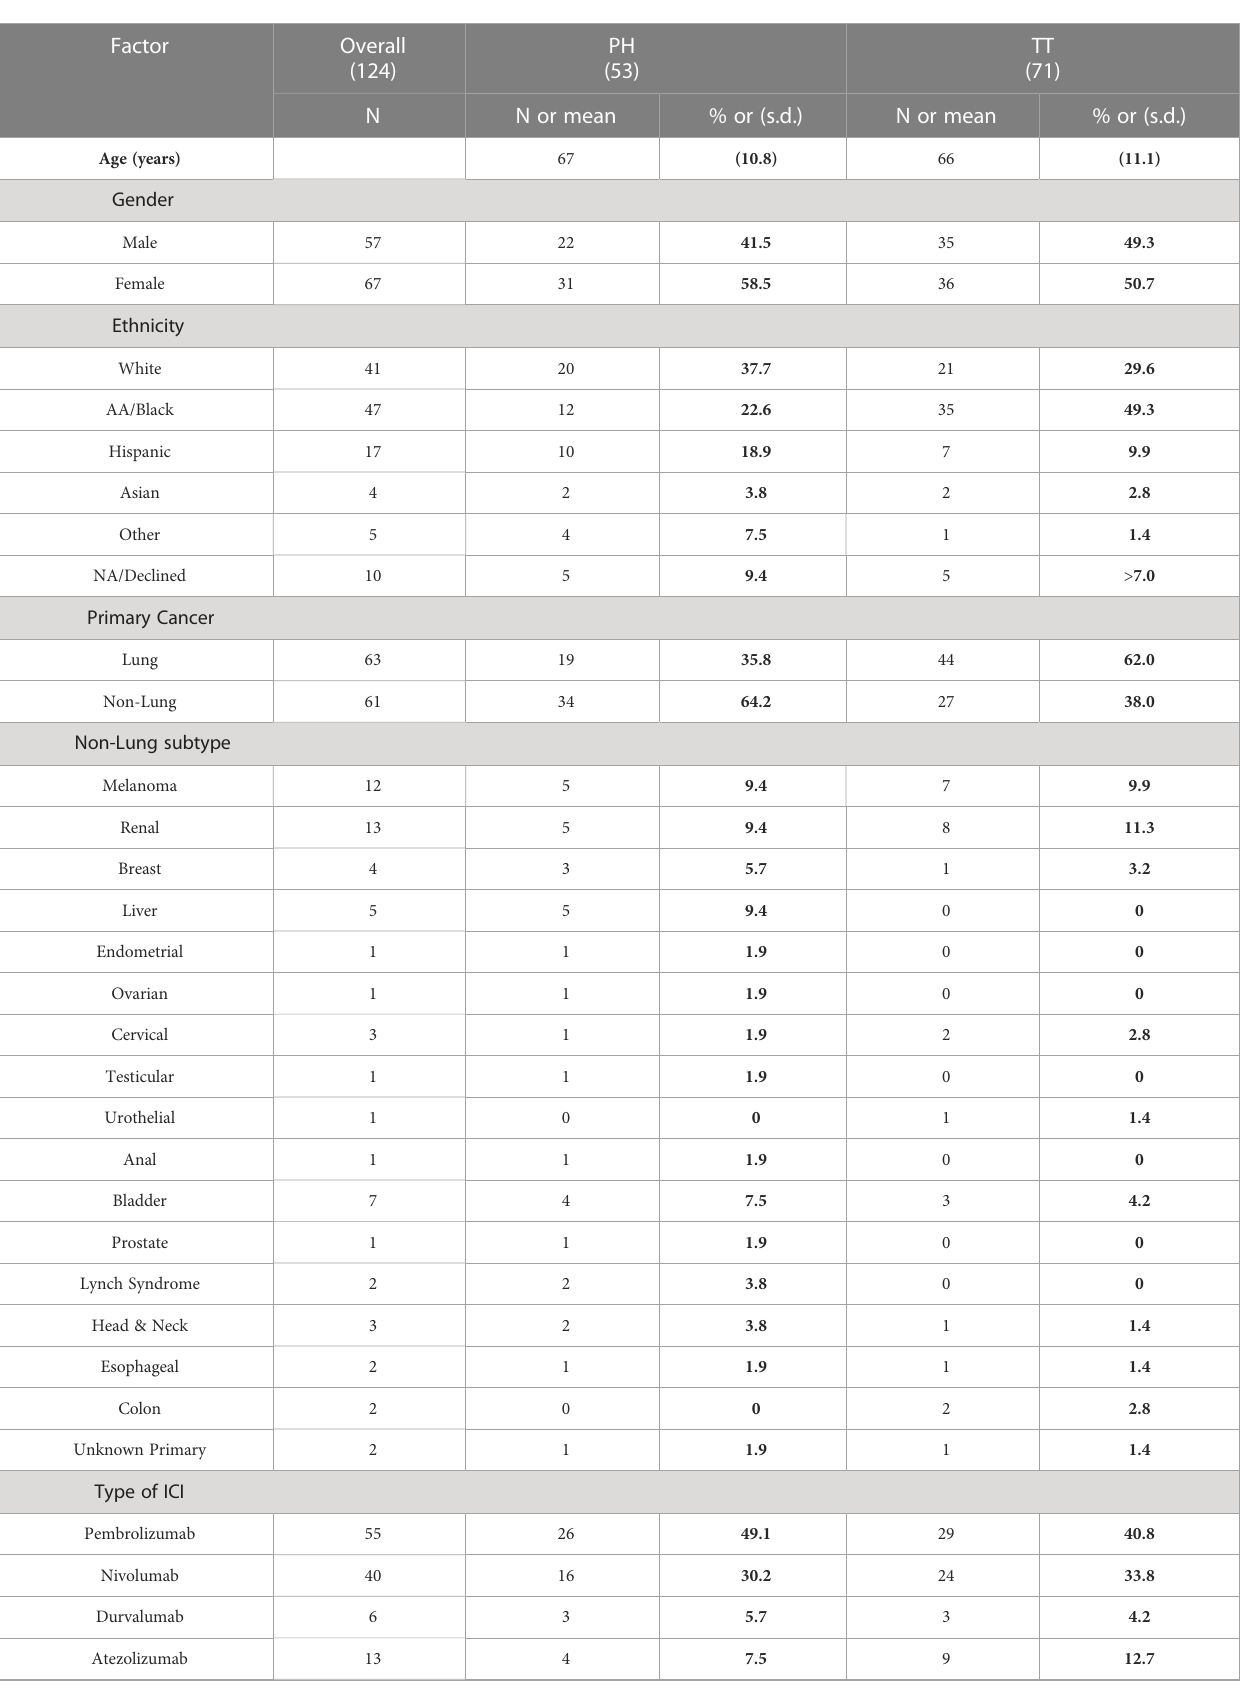
TABLE 1 Patient characteristics in PH vs